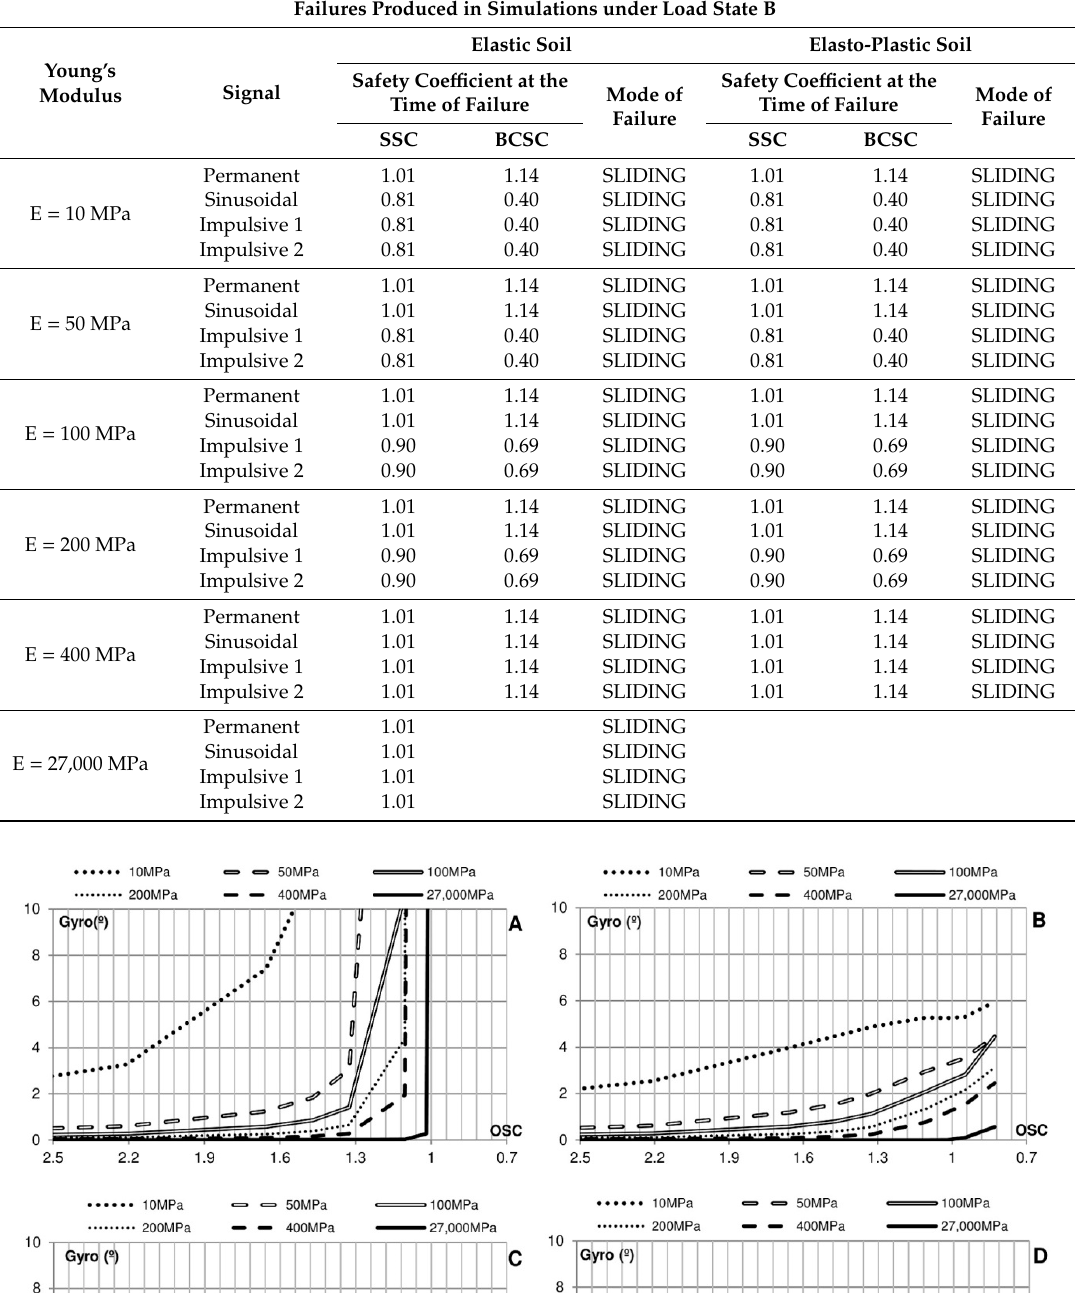
Table 8. Modes of failure in the simulations carried out under load state B and safety coe ffi cients obtained at failure.